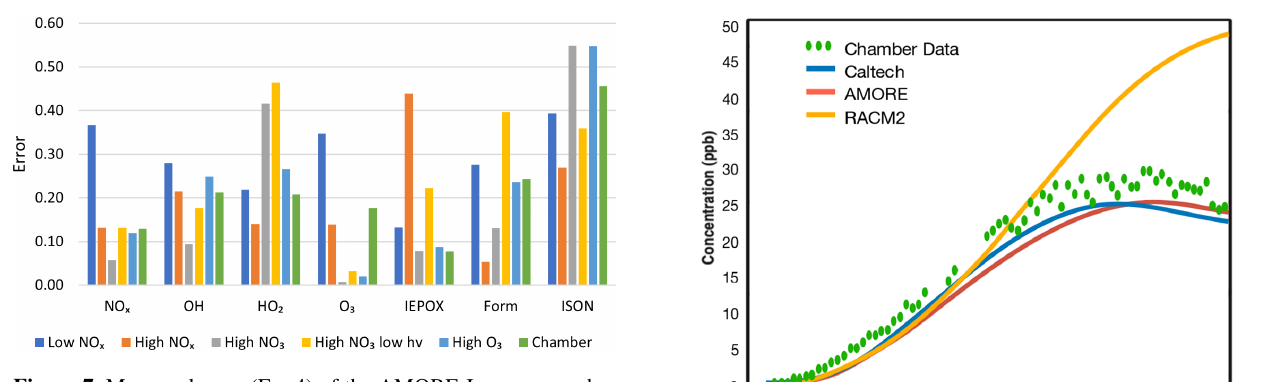
Figure 7. Measured error (Eq. 4) of the AMORE-Isoprene mecha- nism under six different conditions for seven select species groups. Errors are averaged between species for multiple-species groups.